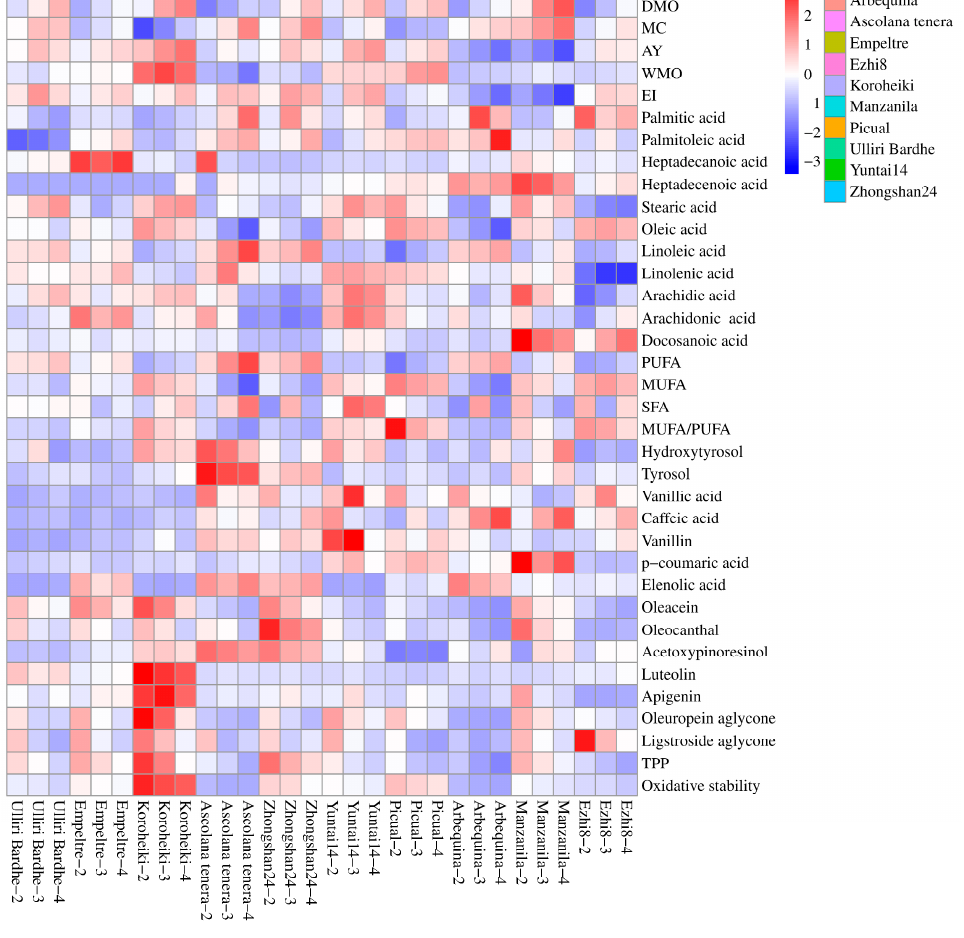
Figure 1. Heat-map visualizing the level of quantity and quality characteristics of VOO from ten varieties with three maturity indices (MI: 2, 3, 4). Red represents high level, and blue represents low level. 1 Dry matter oil content (DMO); moisture content (MC); wet matter oil content (WMO); extractability index (EI); abencor yield (AY); saturated fatty acid (SFA), polyunsaturated FA (PUFA), monounsaturated fatty acid (MUFA), total polar phenolics (TPP).